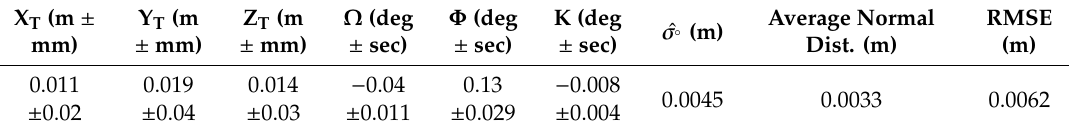
Figure 27. Cross sections illustrating the alignment quality of MLS point clouds from two drive runs in the same direction of the MSE wall at Site-2. Table 9. Estimated transformation parameters and quality measures (square root of a-posteriori variance factor, average normal distance among point-patch pairs, and RMSE of the normal distances)